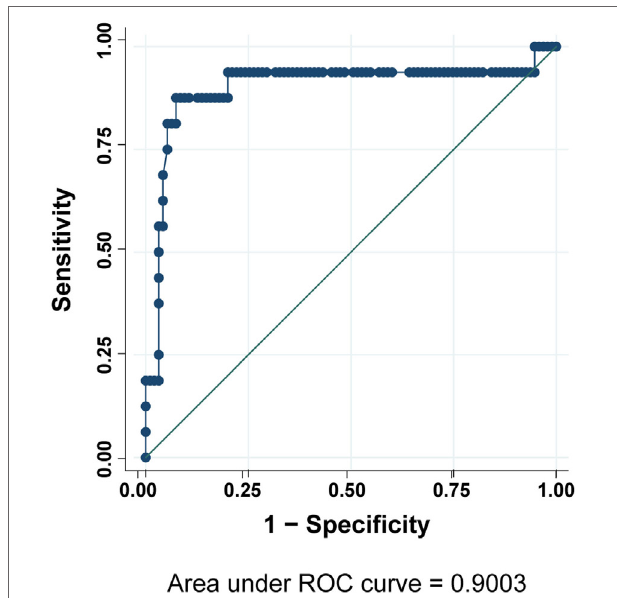
FIGURe 4 | Receiver operating characteristic (ROC) curve analysis for LRBA protein expression. Analysis was done on 57 sequenced patients and 54 healthy donors.